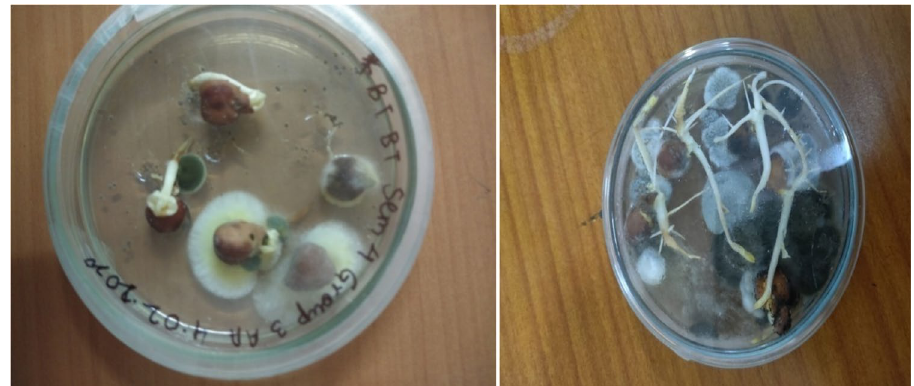
Figure 2. A look at fungi appearing on the chickpea food